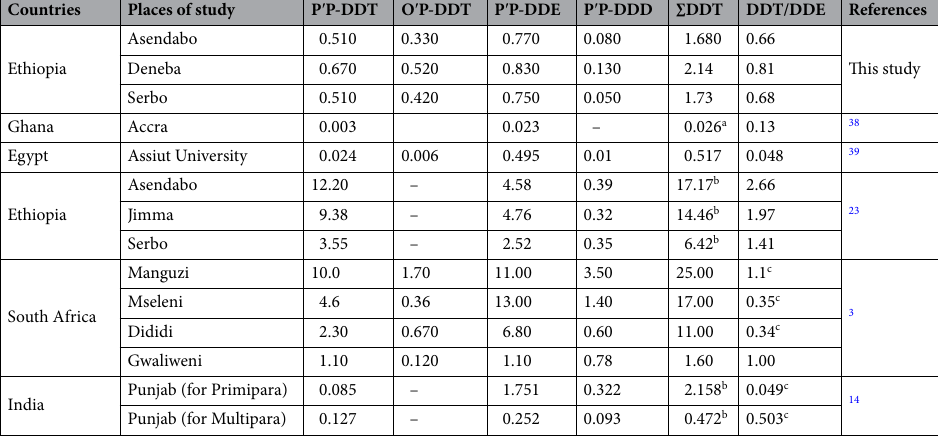
Table 2. Comparisons of the mean concentration (µg/g milk fat) of DDT and its metabolites in three regions with literatures. a ∑DDT = P ′ P-DDT + P ′ P-DDE, b ∑DDT = P ′ P-DDT + P ′ P-DDE + P ′ P –DDD, c.